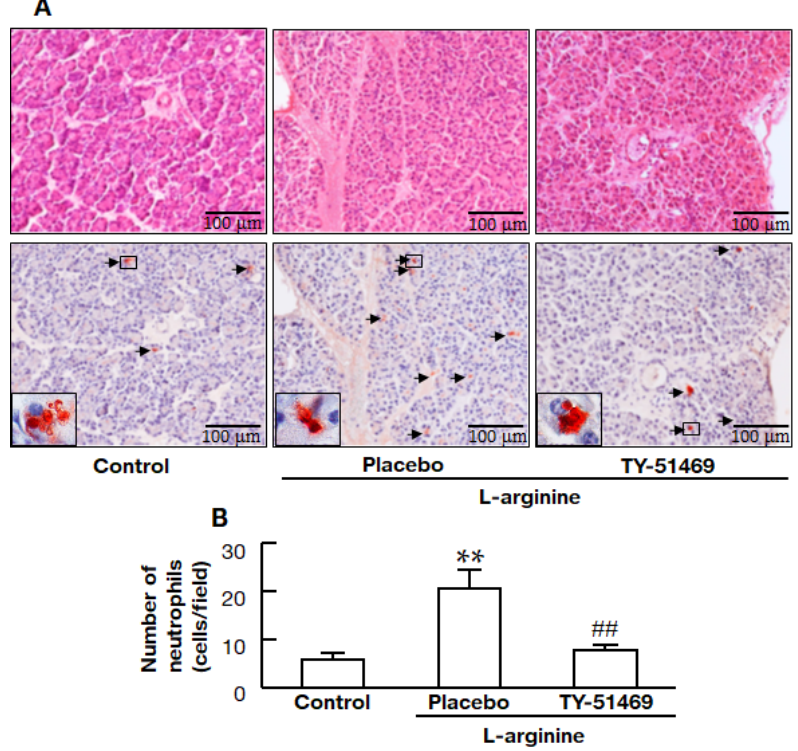
Figure 4. Effects of TY-51469 on neutrophil numbers in the pancreas. Representative images of a pancreas stained with HE stain (upper images) and immunostained with anti-neutrophil elastase antibody (lower images) from the control, placebo-, and TY-51469-treated hamsters 8 h after the injection of L-arginine ( A ). Arrows indicate neutrophil elastase-positive cells ( A : lower images). Original magnification 200× (inset: 1000×) ( A ). The number of neutrophil elastase-positive cells (neutrophils) in the pancreas in control, placebo-, and TY-51469-treated groups 8 h after the injection of L-arginine (control group: n = 6, placebo-treated group: n = 8, TY-51469-treated group: n = 8) ( B ). Values represent means ± SEM. ** p < 0.01 vs. control group. ## p < 0.01 vs. placebo-treated group.